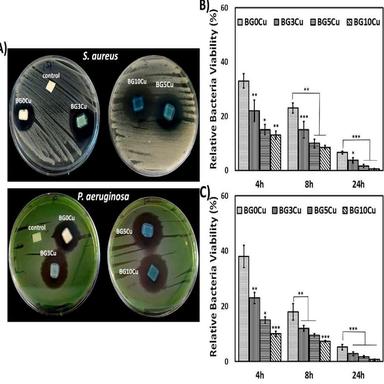
(A) A disc diffusion assay to evaluate the antibacterial potential of the modified bioactive glasses (BGs). The inhibition halos of the modified BGs and control discs against the growth of S. aureus and P. aeruginosa strains after 24 h incubation at 37 -C. A relative bacteria viability rate in the presence of the modified BGs on (B) S. aureus (C) P. aeruginosa bacteria in different time points, indicating that the BG5Cu and BG10Cu glasses significantly decreased the bacteria viability after 24 h. Data provi